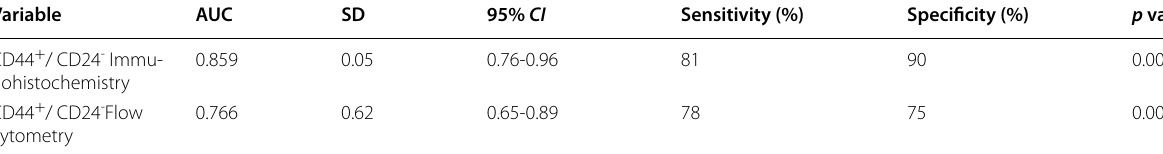
* p < 0.05, significant results